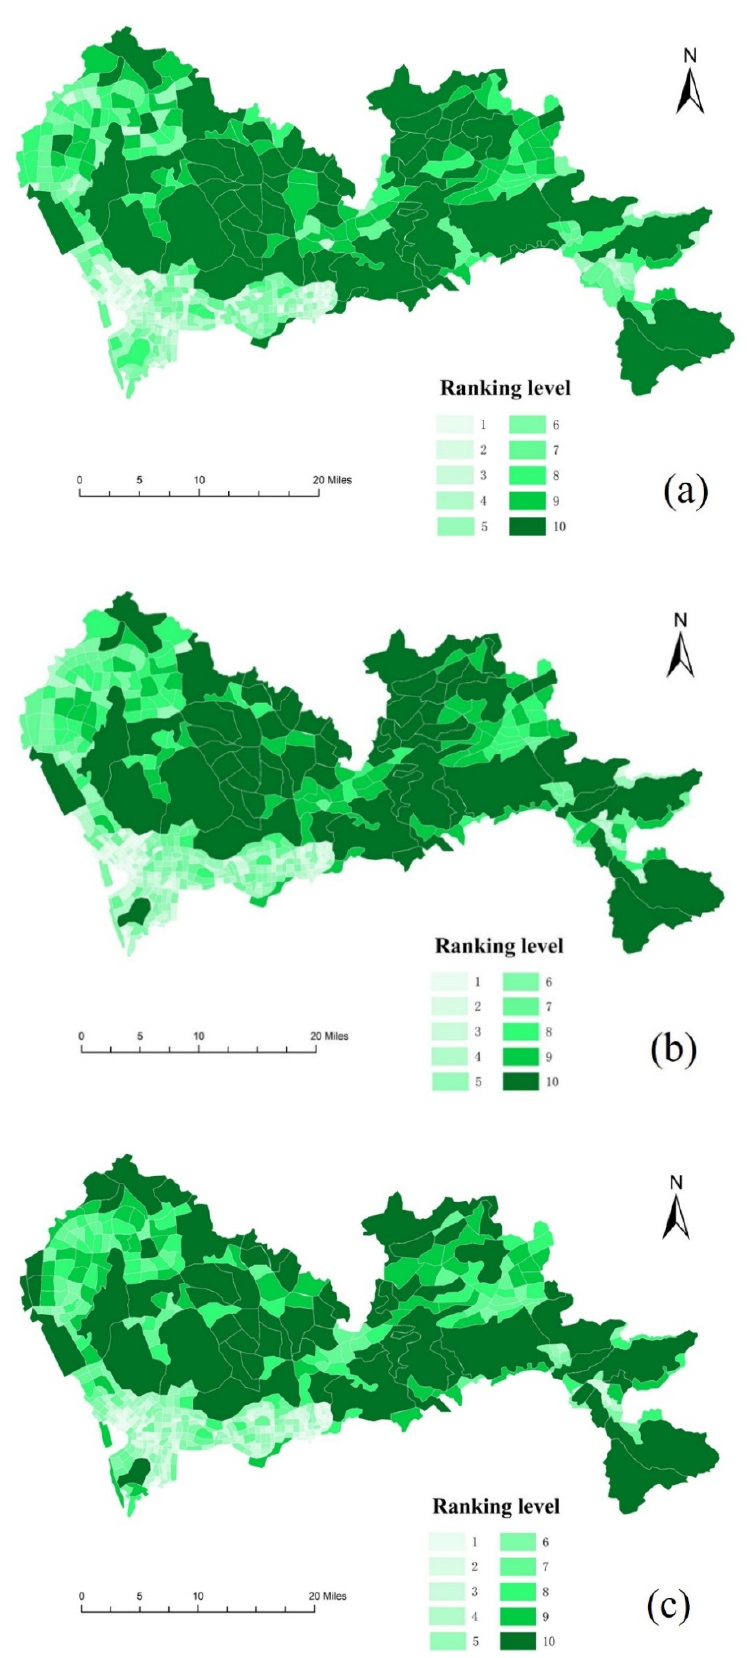
Figure 5. Economic cost ranking level under various scenarios: ( a ) Scenario 1; ( b ) Scenario 2; ( c ) Scenario 3.